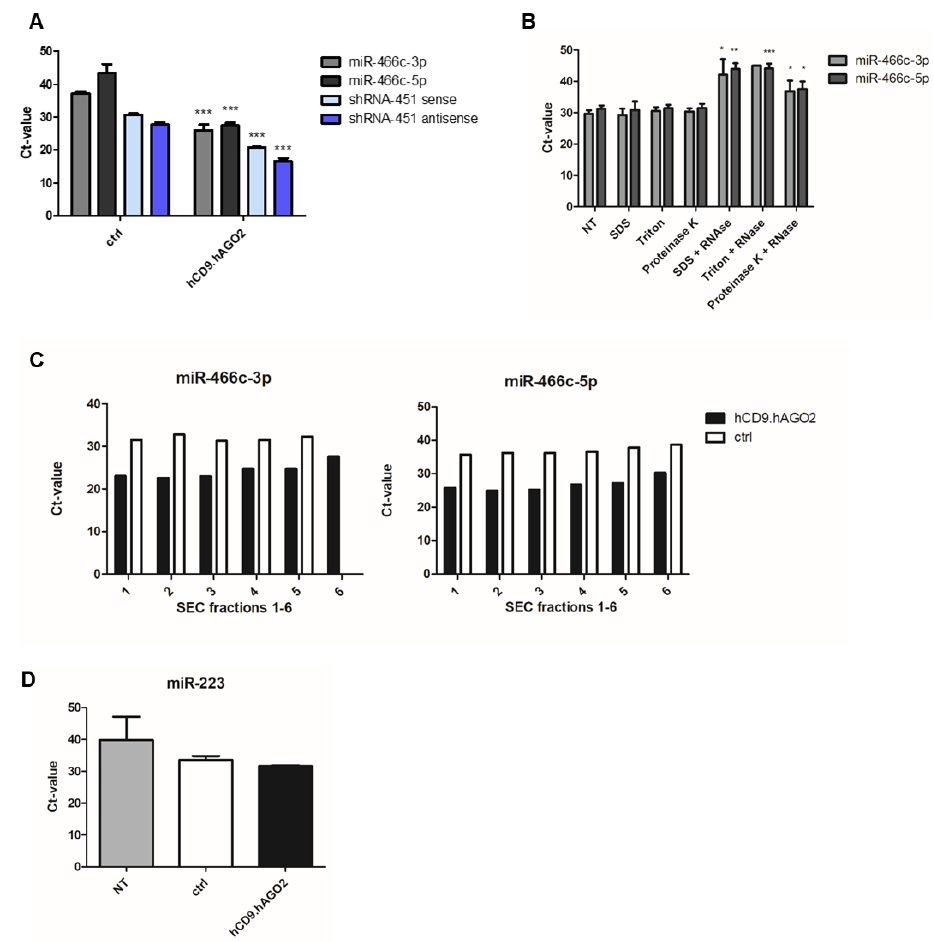
Figure 2. RNA-loading to EVs using the fusion protein hCD9.hAGO2. ( A ) The capability of hCD9.hAGO2 fusion protein in loading of both miR-466c and shRNA-451 in the secreted EVs was significantly increased compared to the control EVs. Data are presented as mean ± SD, n = 3. Two-tailed Student’s t -test: miR-466c-3p ctrl vs. hCD9.hAGO2 p -value 0.0005; miR-466c-5p ctrl vs. hCD9.hAGO2 p -value 0.0006; shRNA-451 sense ctrl vs. hCD9.hAGO2 p -value < 0.0001; shRNA-451 antisense ctrl vs. hCD9.hAGO2 p -value < 0.0001; ( B ) EVs loaded with miR-466c using hCD9.hAGO2 were treated with membrane disrupting agents (SDS, Triton) and protein degradation enzyme (Pro- teinase K) in combination with RNase A in order to see whether the miRNA is packed inside of the EVs (protected by the membrane) or outside of the EVs (in contaminating protein complexes). SDS and Triton treatments combined with RNase A caused total degradation of miR-466c as expected. Proteinase K treatment followed by RNase A did not result in as much degradation, suggesting that miR-466c is protected inside the EVs. Data are presented as mean ± SD, n = 3. Two- tailed Student’s t -test: miR-466c-3p SDS vs. SDS + RNase A p -value 0.0149; miR-466c-3p Proteinase K vs. Proteinase K + RNase A p -value 0.0352; miR-466c-5p SDS vs. SDS + RNase A p -value 0.0025; miR-466c-5p Triton vs. Triton + RNase A p -value 0.0003; miR-466c-5p Proteinase K vs. Proteinase K + RNase A p -value 0.0192; ( C ) From the SEC EV isolation fractions the earlier fractions (1 – 3) contain more miR-466c and the levels decrease starting from the fraction 4. This was seen more clearly in the hCD9.hAGO2 engineered EVs, as the levels of miR-466c are higher in the fusion protein loaded EVs than in control EVs with endogenous loading only; ( D ) After loading miR-466c to EVs either using hCD9.hAGO2 fusion protein or endogenous loading (control), we compared the expression of hsa-miR-223 be- tween the groups and non-treated HEK293T-derived EVs (NT). hCD9.hAGO2 loading also in- creased the loading of endogenously expressed hsa-miR-223 even together with miR-466c overex- pression in the cells. Data are presented as mean ± SD, n = 2. * p -value < 0.05, ** p -value < 0.005, *** p -value < 0.0005.